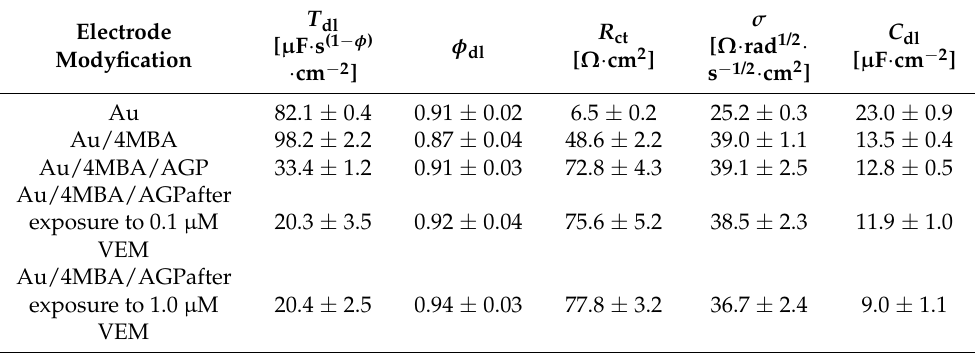
Table 1. EIS parameters ( n = 3) (capacitive parameter- T dl and exponential factor- φ dl of the constant phase element (CPE); charge transfer resistance- R ct ), Warburg parameter- σ , and double layer capacity- C dl ) for each step of electrode modification and VEM interactions with